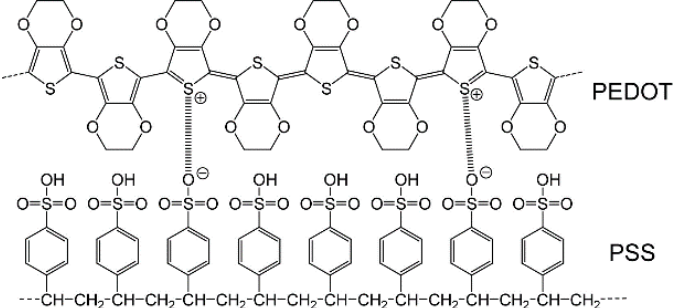
Figure 11. Chemical structure of PEDOT:PSS.